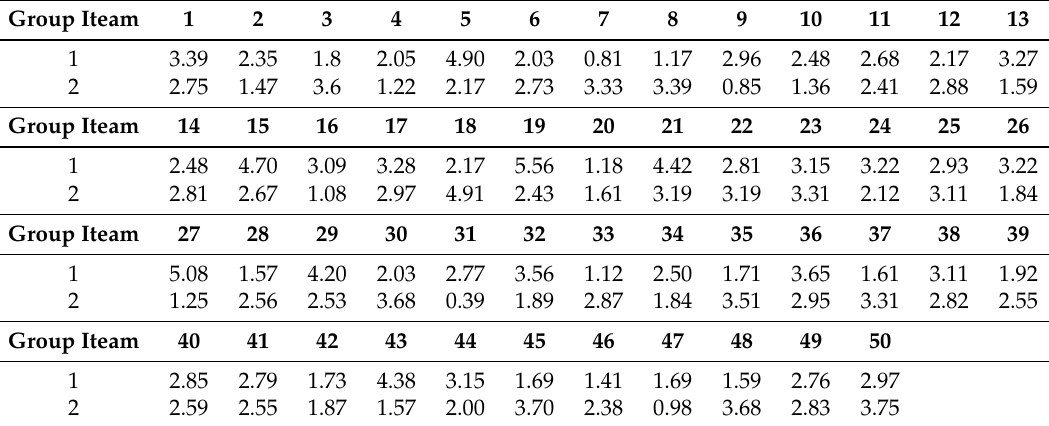
Table 23. The grouped